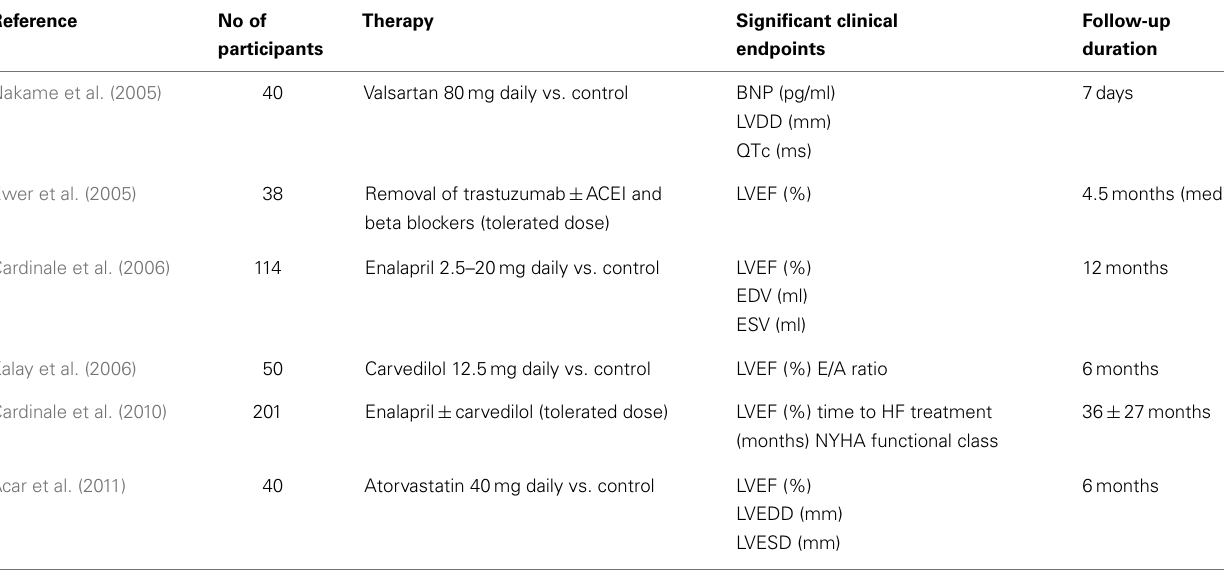
Table 1 | Clinical studies of medical therapy in chemotherapy-induced